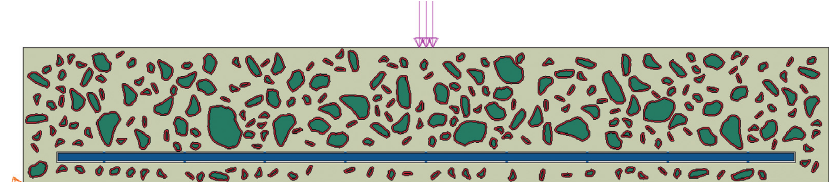
Figure 4: The three-point bending RC beam.